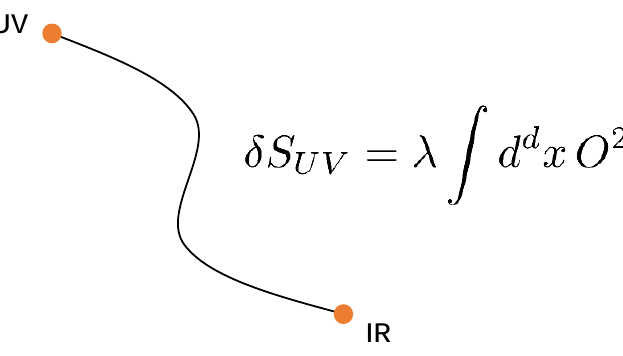
Figure 1 . A renormalization group (cid:13)ow triggered by a double-trace deformation of a large- N CFT: the UV (cid:12)xed point, at which the operator O has (cid:1) < d= 2, (cid:13)ows to an IR (cid:12)xed point, at which O has conformal dimension d (cid:0) (cid:1), at leading order in 1 =N . In this paper, we compute the leading order change in four-point functions of single-trace operators, other than O , that couple to O